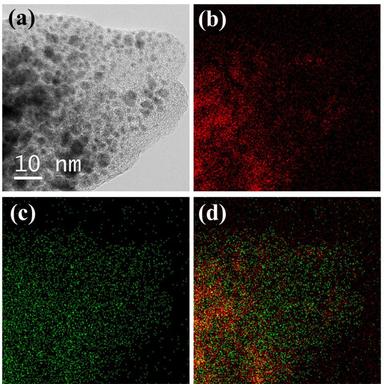
(a) Another example of a TEM image of an AuNP in region 1, and (b, c) corresponding EDS mapping for Au and C, respectively, together with (d) a merged image of (b) and (c).